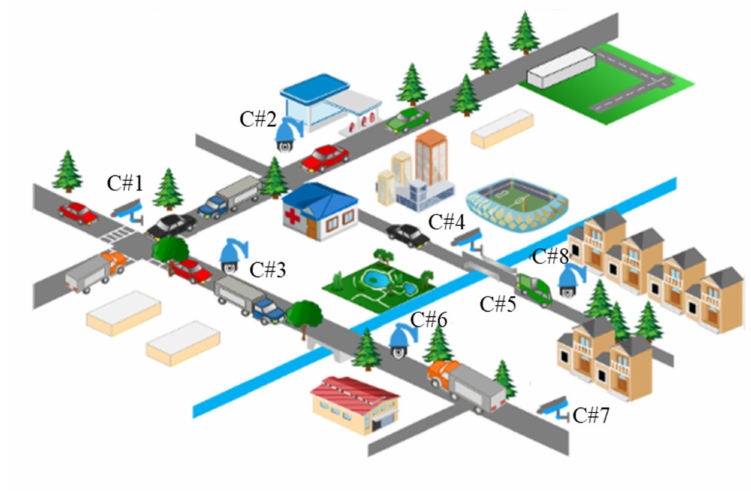
Figure 3. Illustrates the practical scenario of surveillance camera